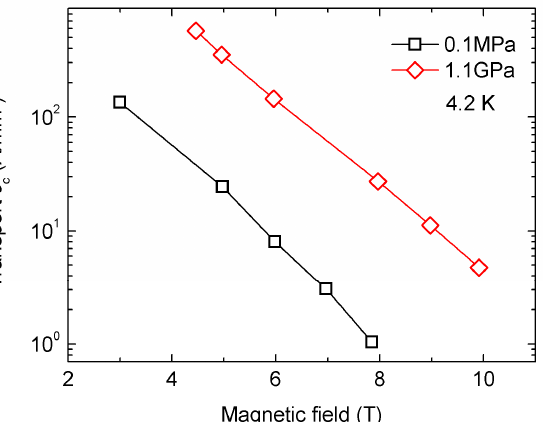
Figure 8. Transport J c of the MgB 2 samples at a pressure of 1.1 GPa and 0.1 MPa. Some data are based on [41]. based on